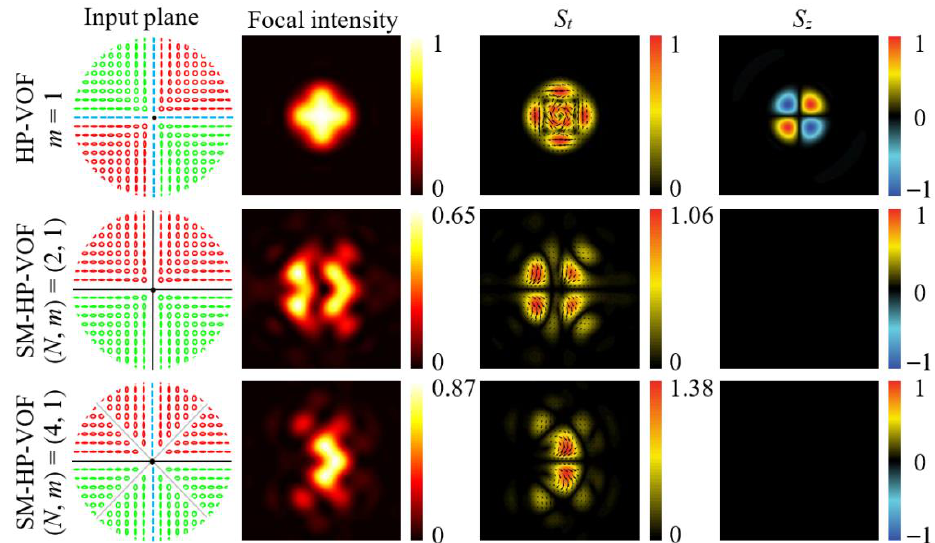
Figure 3. The polarization states of the HP-VOF and the SM-HP-VOF in the input plane are shown in the first column, and the total intensity, transverse SAM density S t , and longitudinal SAM density S z in the focal plane are shown in the second to fourth columns. The first row shows the cylindrical HP-VOF when m = 1 , and the second and third rows show the SM-HP-VOF when ( N , m ) = (2, 1) and (4, 1), respectively. The blue, red and green polarizations in the first column represent linear, right- and left-handed elliptic (circular) polarizations, respectively. The arrows in the third column indicate the direction of the transverse SAM density. The numerical aperture of the focal lens is NA = 0.95, and any picture in the focal plane has a size of 4 λ × 4 λ , with λ being the wavelength.